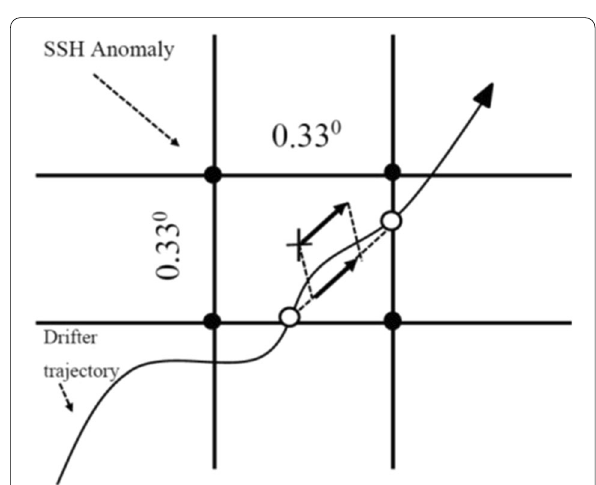
Fig. 3 Schematic diagram showing the method to calculate a velocity from a low-pass filtered drifter trajectory (adapted from Uchida and Imawaki 2003). The velocity for a 1/3° and longitude box defined by grid points of the altimeter data set is calculated from two positions (open circles) and time where and when a drifter comes in and goes out of the